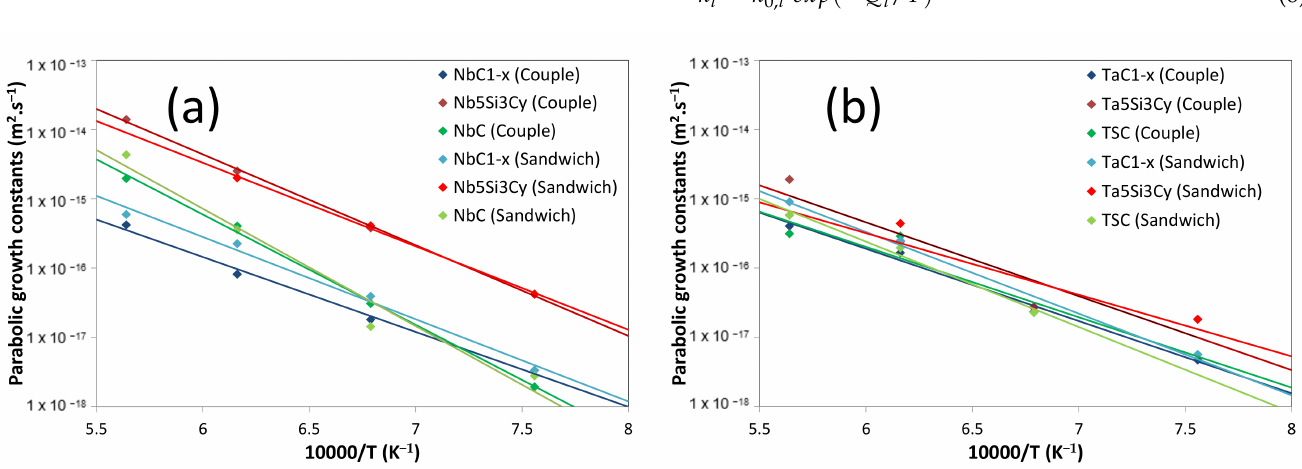
Figure 17. Parabolic growth constants ( k ) of each layer as a function of the inverse of the temperature in Nb/SiC ( a ) and Ta/SiC ( b ) systems. TSC = group layer corresponding to the Ta 5 Si 3 , Ta 2 C and Ta 2 Si ensemble. NbC = group corresponding to NbC 1 − z and Nb 2 C ensemble.